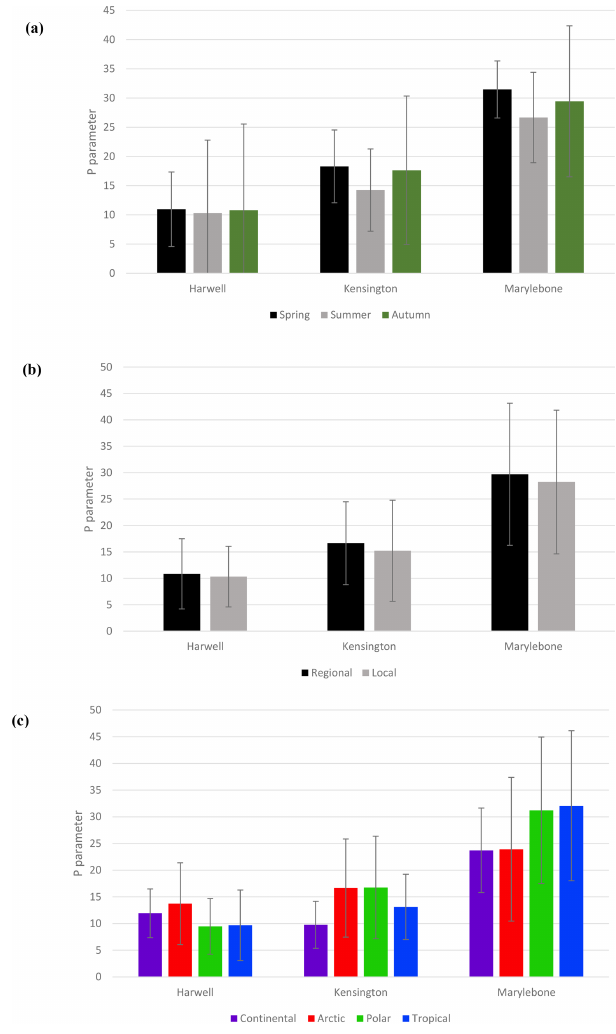
Figure 7. Survival parameter P (a) per season, (b) for regional and local events (for Marylebone Road regional is for all three sites), and (c) by incoming air mass